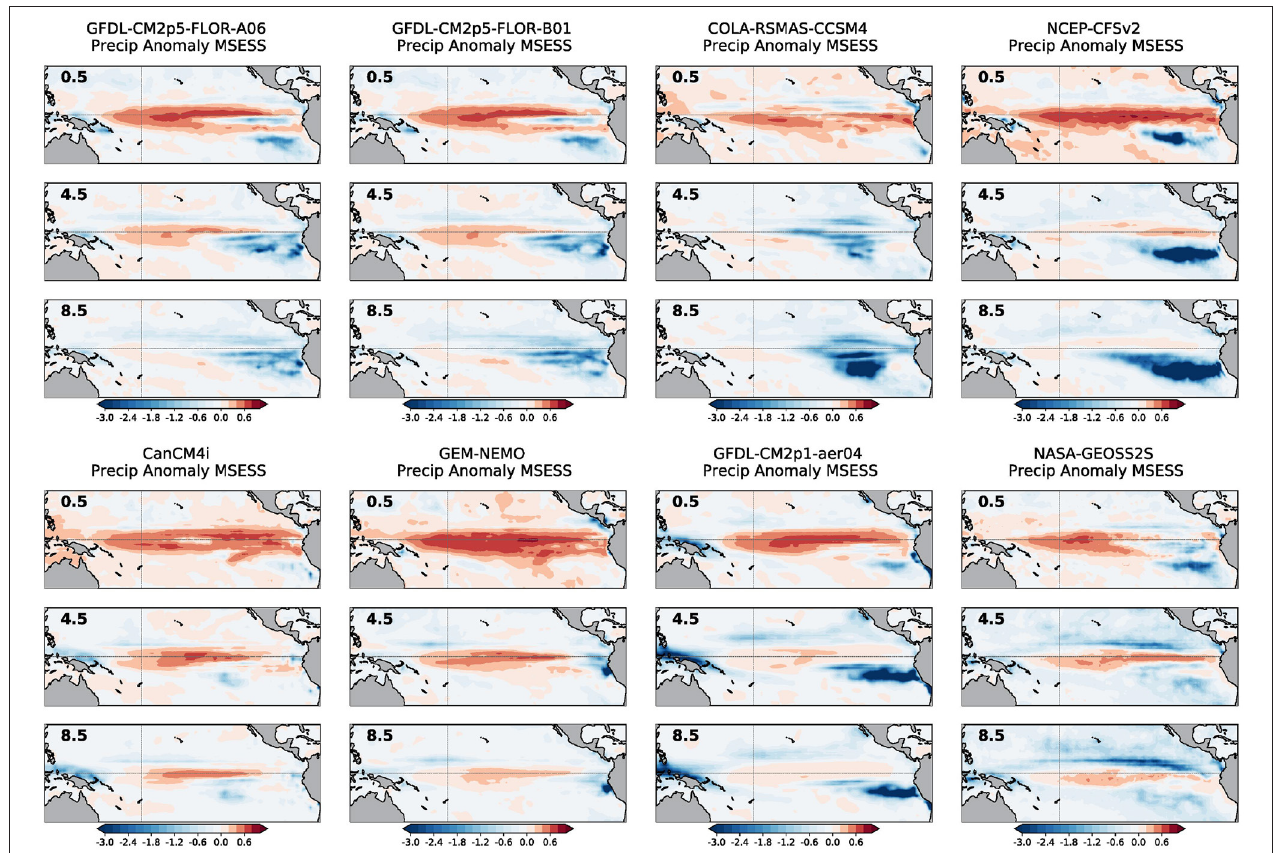
FIGURE 5 | As in Figure 2 except showing the mean squared error skill score (MSESS) in precipitation anomalies from January 1982 to December 2020. Warm (cool) colors indicate forecast skill greater (less) than climatology. Values are unitless and range from minus infinity to one.